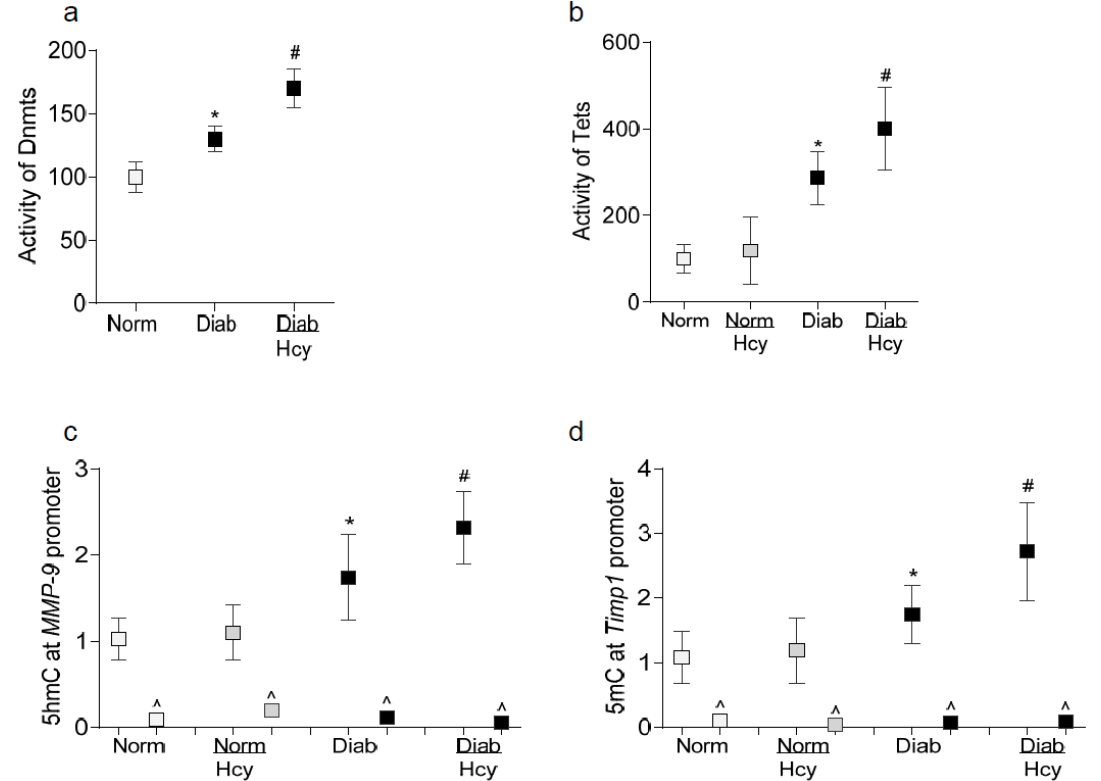
Figure 6. Homocysteine and DNA methylation status of MMP-9 and Timp1 promoters. Activities of ( a ) Dnmts and ( b ) Tets was quantified in retinal nuclear fraction using DNA Methyltransferase or Hydroxymethyltransferase Activity/Inhibition kits . The values from normal control rats were considered as 100%. The levels of ( c ) 5 hmC at the MMP-9 promoter, and ( d ) 5 mC at the Timp1 promoter were measured using by hydroxymethylated and methylated DNA immunoprecipitation methods, respectively. As an antibody control, IgG (^) was used. The vales from normal control rats were considered as one. Each measurement was made in duplicate in 5–6 rats/group. * p < 0.05 compared to normal and # p < 0.05 compared to diabetes.